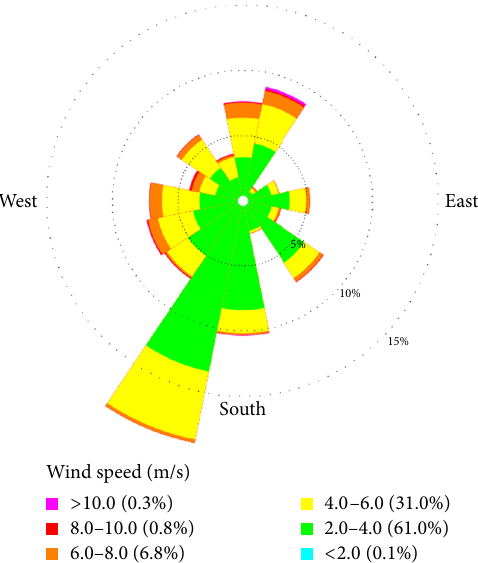
Figure 9: Polar diagram: wind direction for Moundou.